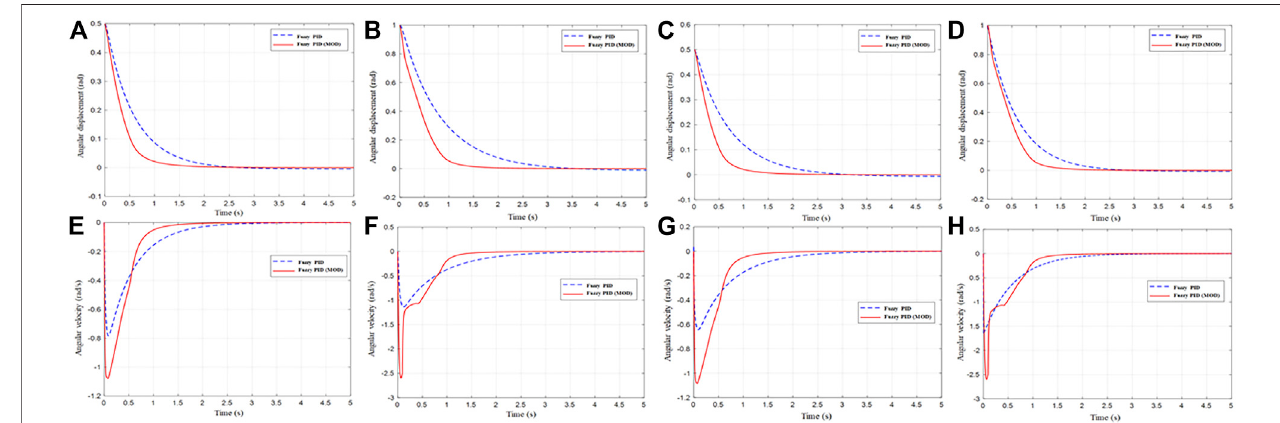
FIGURE13| Positioningcontrolresponseoftheangulardisplacementandangularvelocity: (A) angulardisplacementofjoints1, (B) angularvelocityofjoints1, (C) angular displacement of joints 2, (D) angular velocity of joints 2, (E) angular displacement of joints 3, (F) angular velocity of joints 3, (G) angular displacement of joints 4, and (H) angular velocity of joints 4.